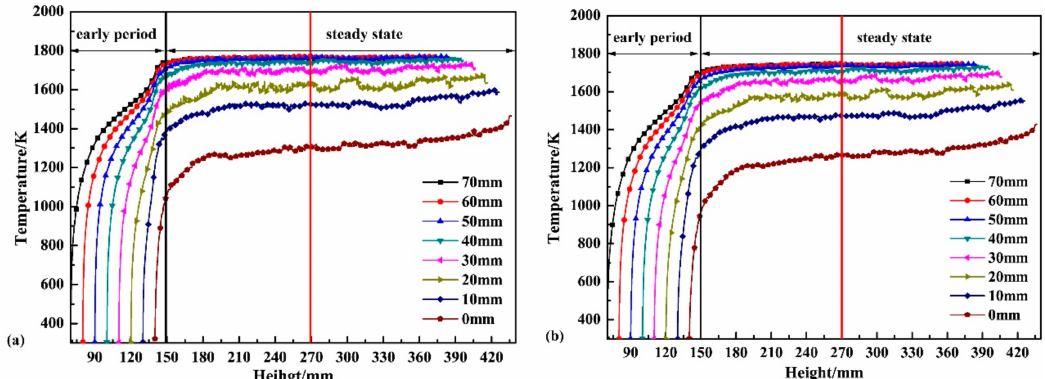
Figure 7. Temperature of depth into the mandrel surface on different heating distance with 40 V: ( a ) 2 mm depth into the mandrel surface; ( b ) 4 mm depth into the mandrel surface.